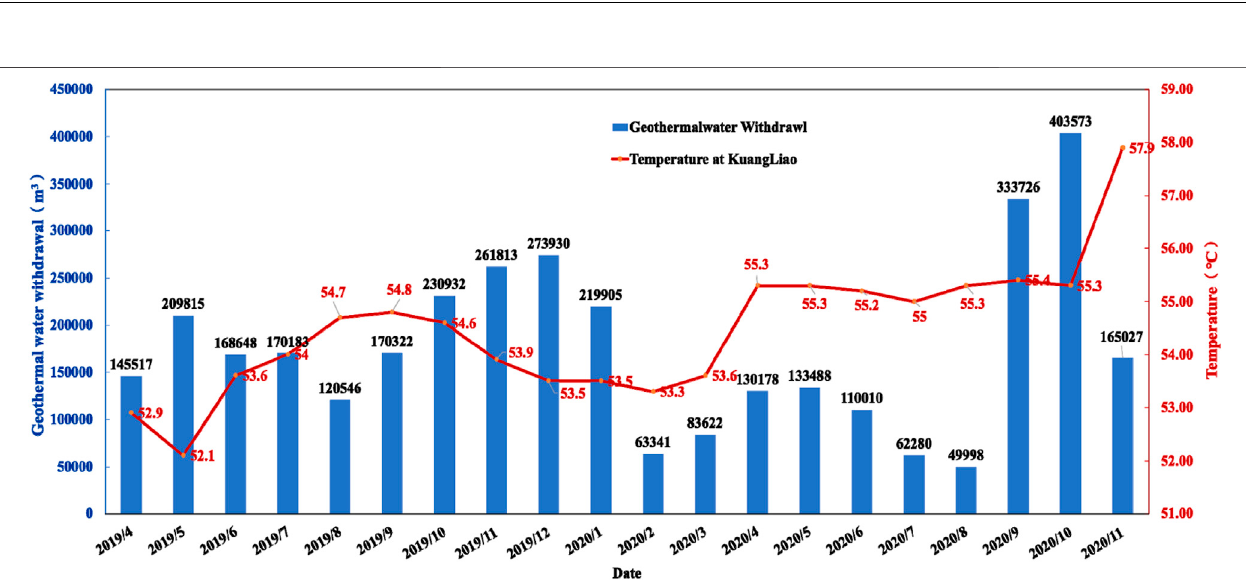
FIGURE 6 | The monthly monitoring data of geothermal water withdrawn and temperature of Kuangliao from April 2019 to November 2020.